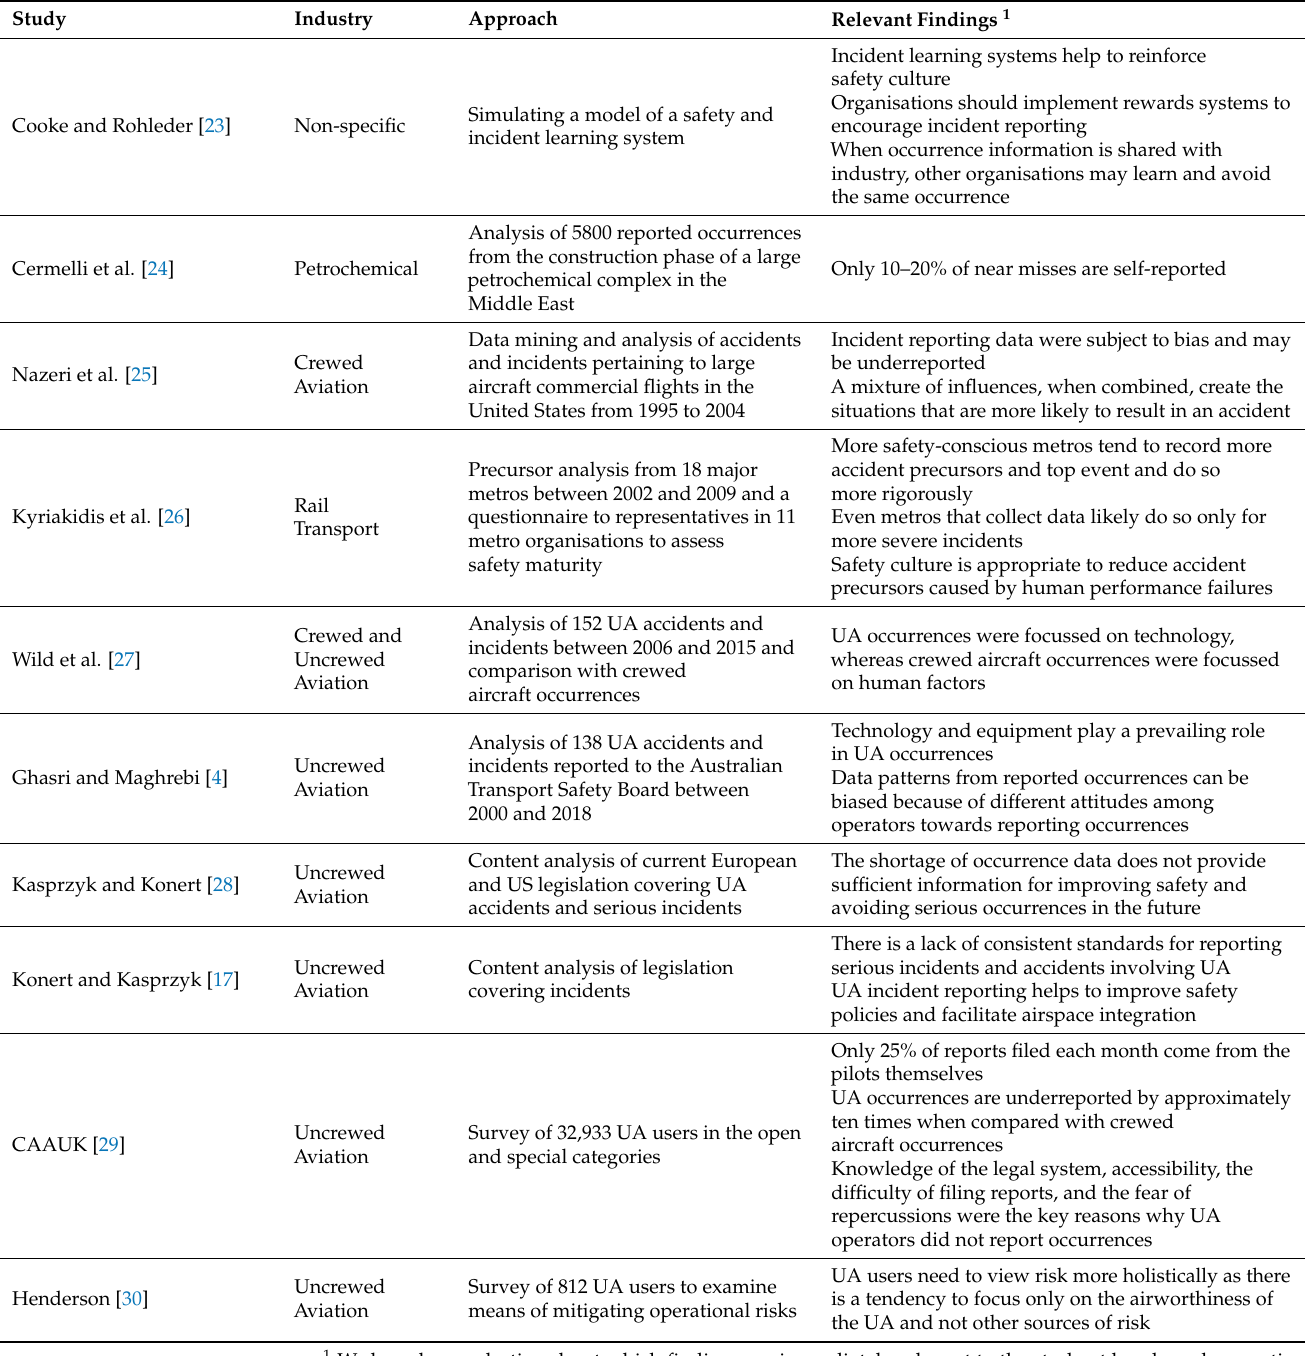
Table 1. Abbreviated summary of past research relevant to UA safety occurrence